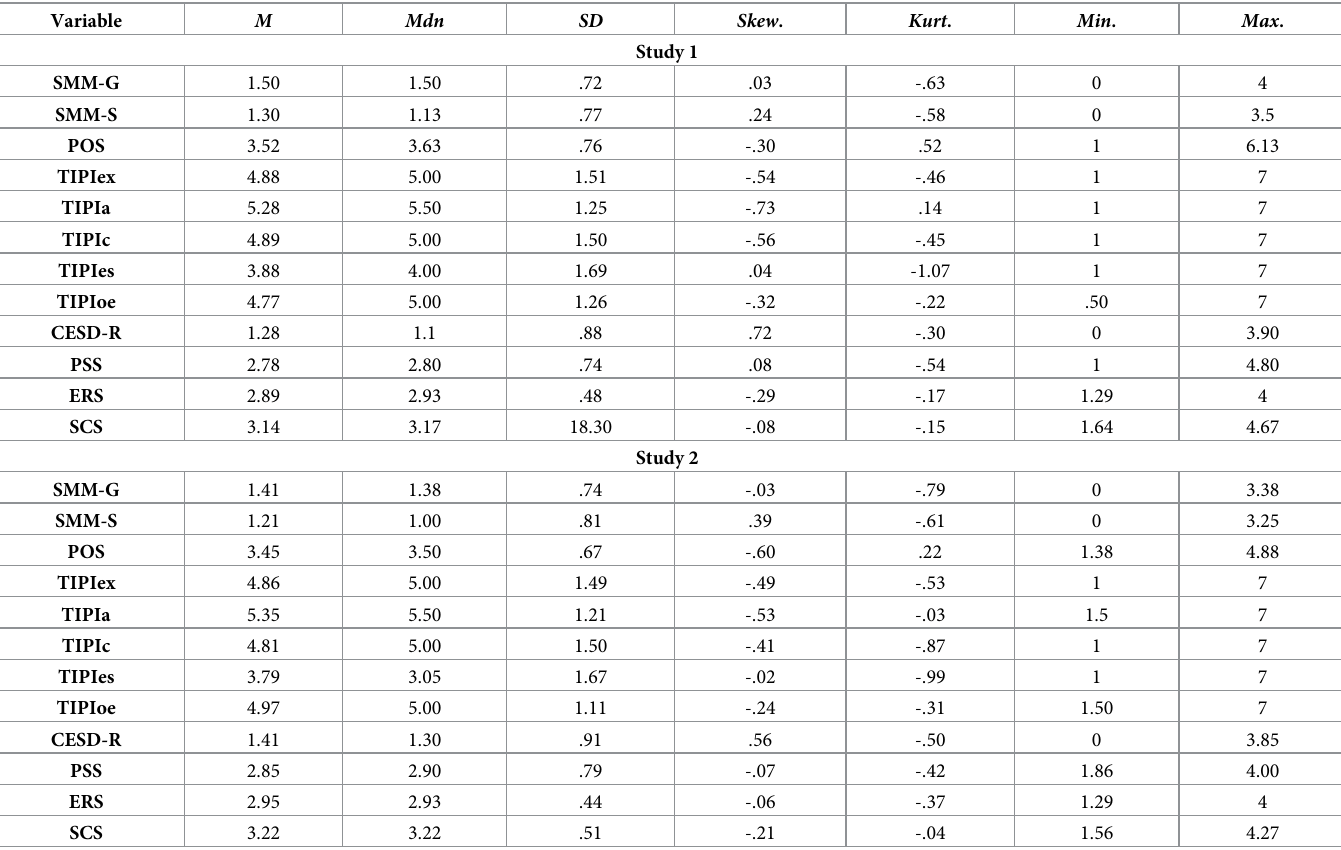
Table 1. Descriptive statistics of the variables with the Kolmogorov-Smirnov